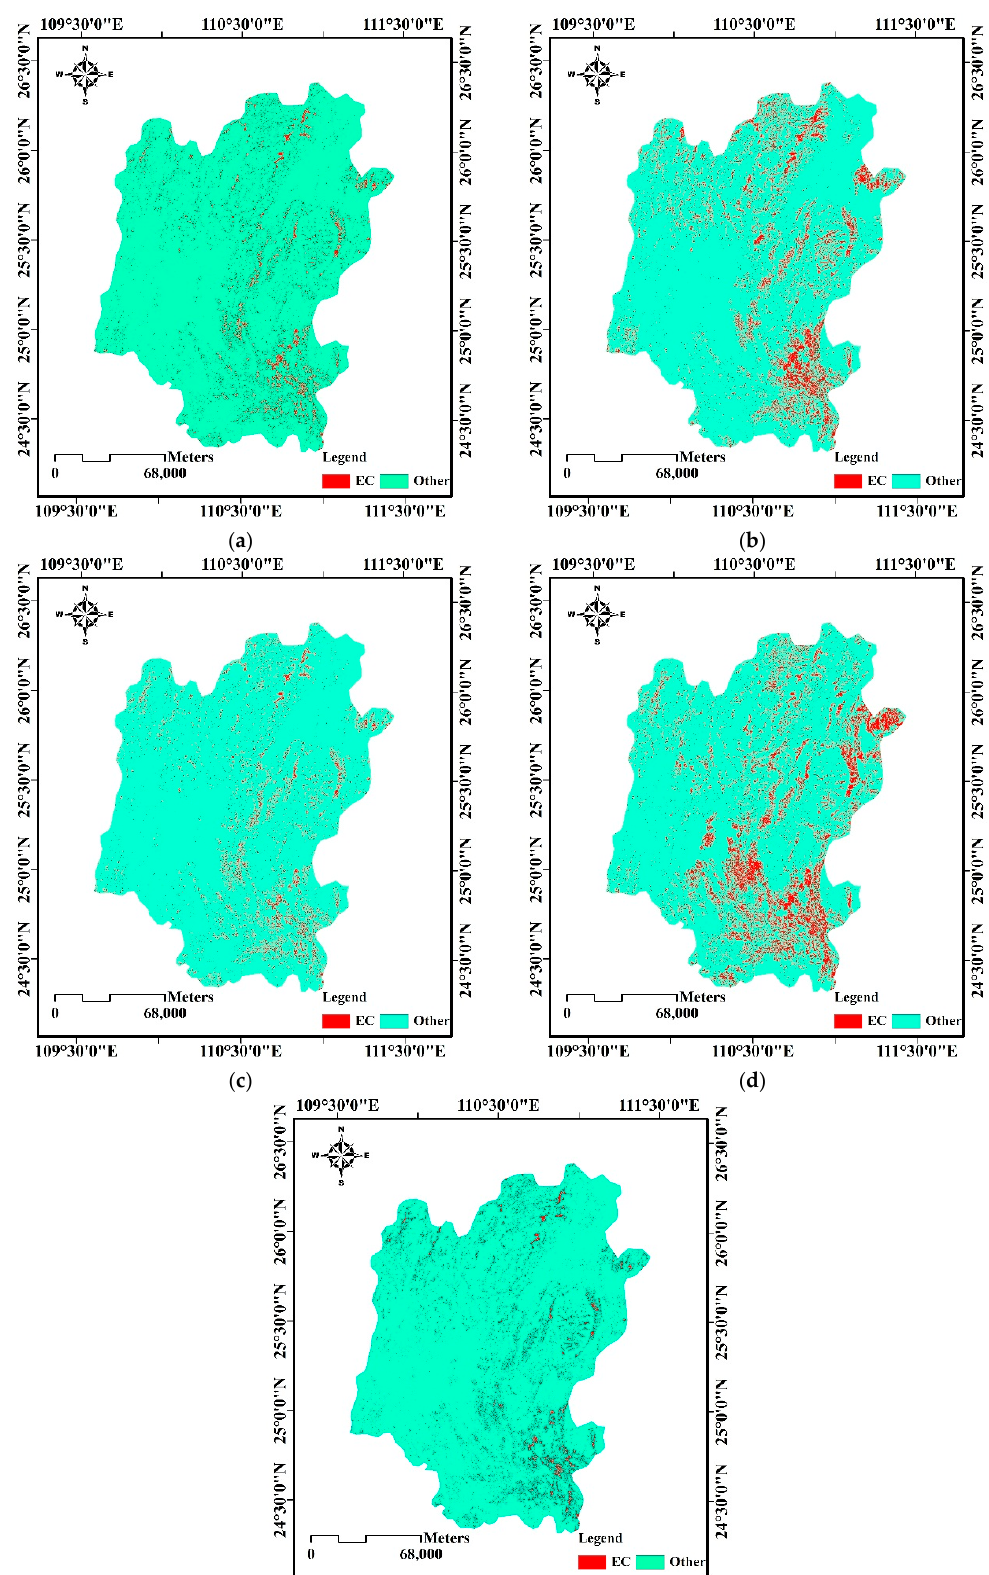
Figure 9. The extraction results of exposed carbonatite in the first test area by: ( a ) the proposed method; ( b ) CL-DT; ( c ) SAE; ( d ) CART; and ( e ) RFs.